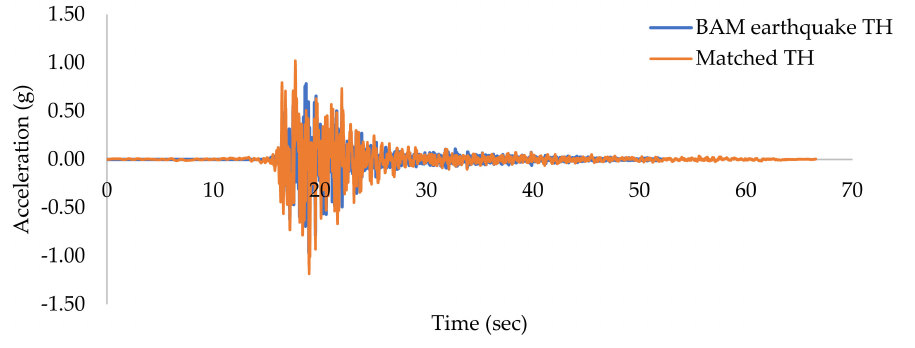
Figure 4. Bam earthquake time history.